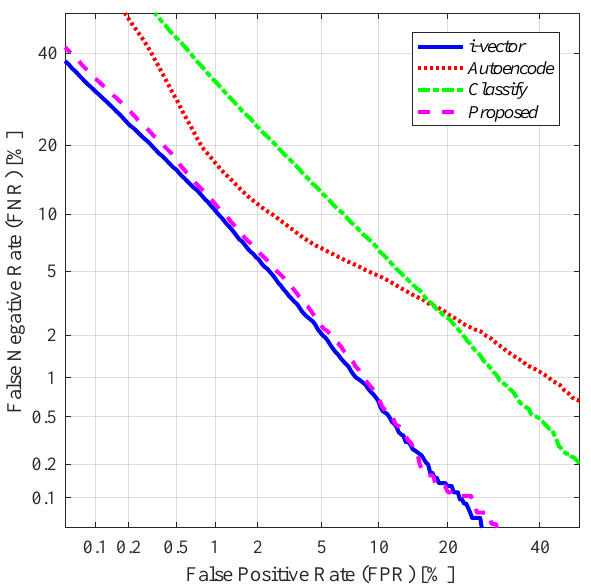
Figure 5. DET curves of the speaker verification experiments using the i-vector and the mean latent variables extracted from VAEs trained for different tasks. Table 1. Comparison of results between using the i-vector and the mean latent variables extracted from VAEs trained for different tasks. Class. Err.: classification error; DCF08: minimum NIST SRE 2008 DCF; DCF10: minimum NIST SRE 2010 DCF; EER: equal error rate.